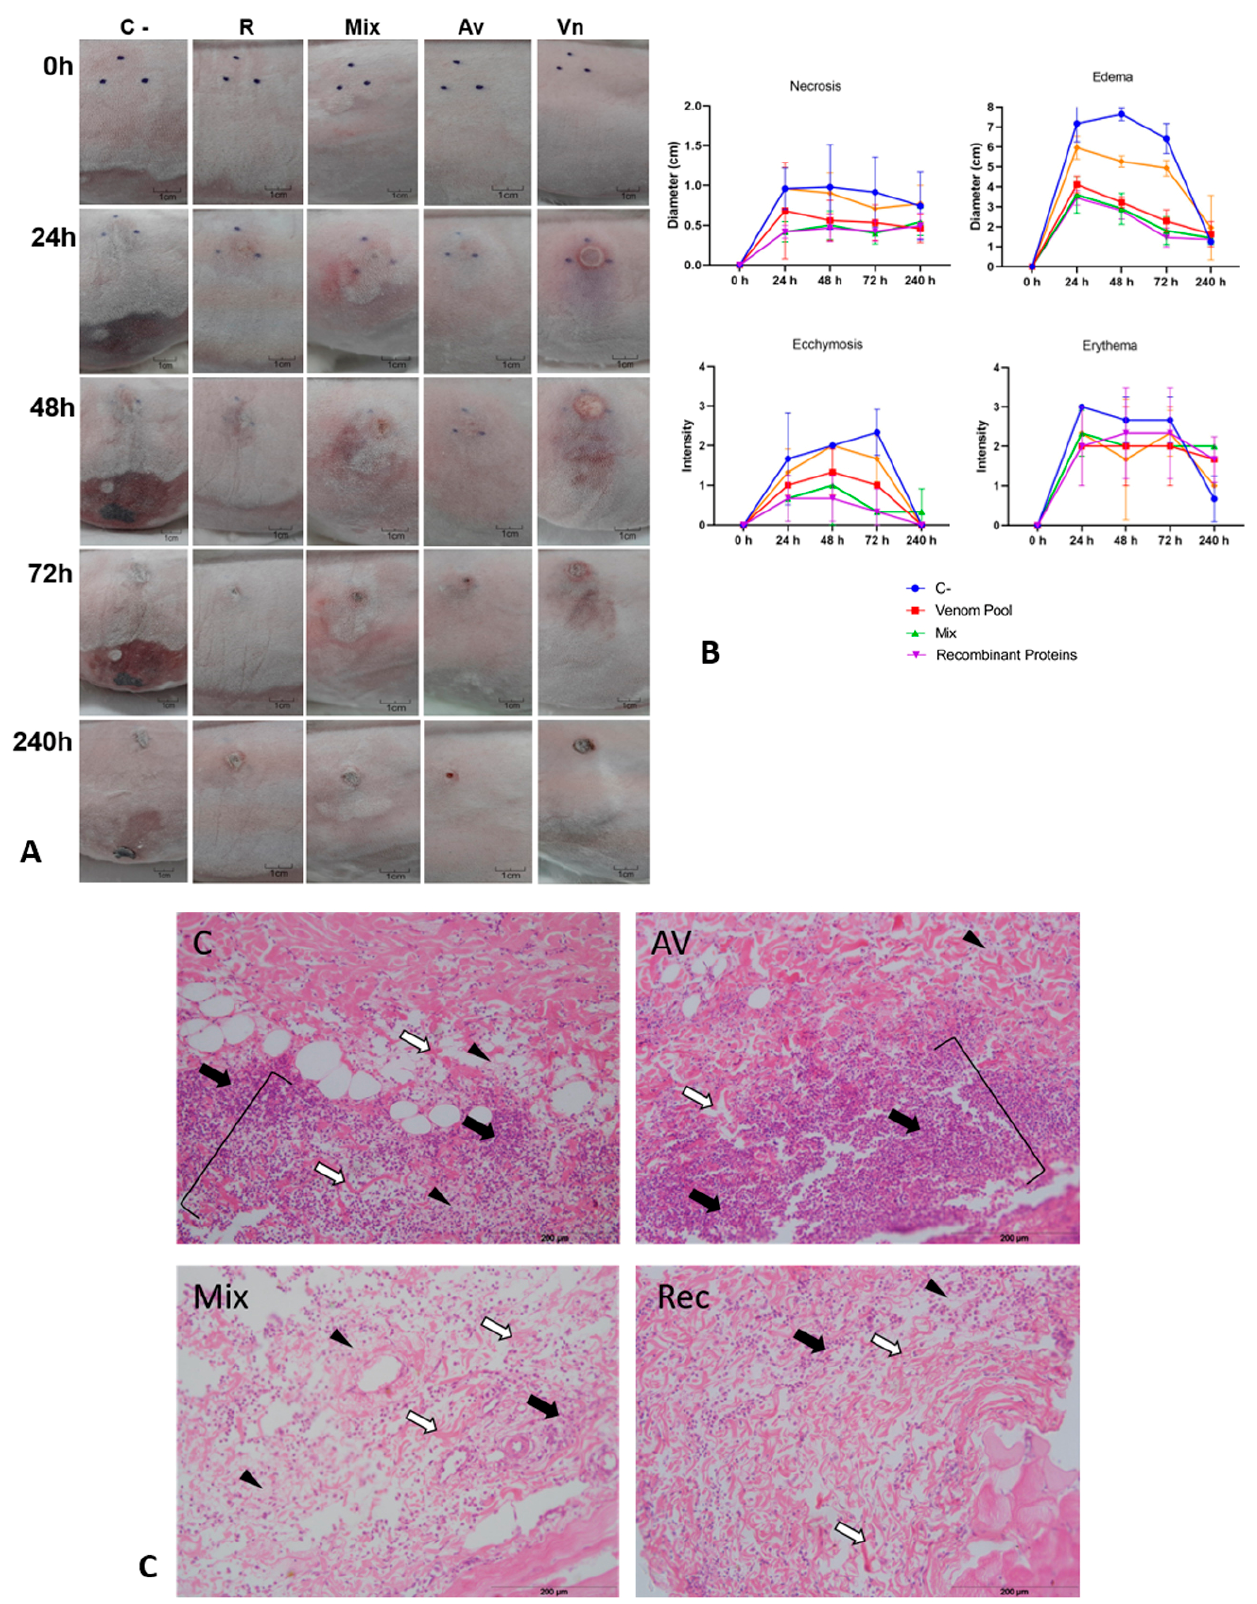
Figure 6. Neutralization of cutaneous loxoscelism triggered by 2 MND of venom tested with pre-incubation. Two MND (6.10 µg) of L. intermedia venom previously incubated with each serum were injected (I.D.) in the back skin of rabbits (groups of five animals). ( A ) Macroscopic aspect of injected area after the indicated time courses. C-: C serum. R: REC serum. M: MIX serum. Av: AV serum. Vn: 2 MND of L. intermedia venom in the absence of serum. Photographs show a representative response to the animals. Black dots marked on the skin surround the local injection. ( B ) Skin